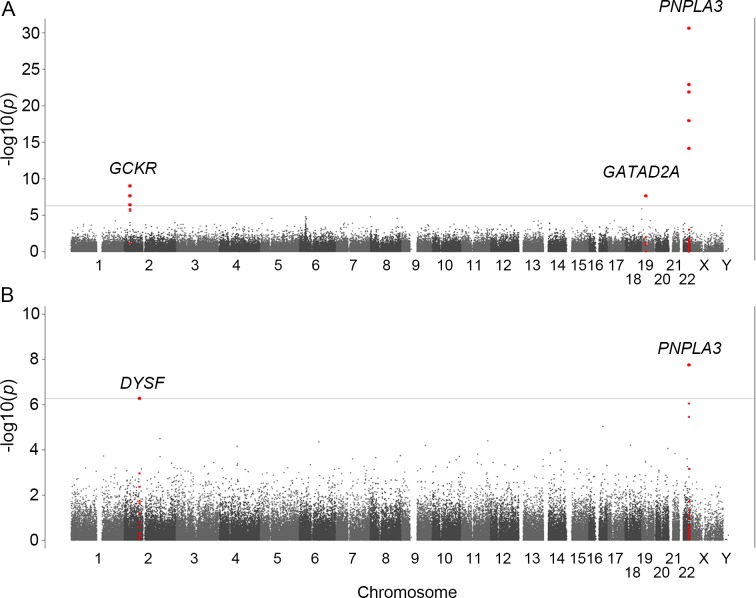
Manhattan plots of the GWA data.The p-values for genotyped SNPs from the GWA study for all NAFLD patients (A) and for NASH-HCC patients (B) compared to controls are plotted along each chromosome in −log10 scale. Horizontal line indicates the Bonferroni significance threshold (p = 5.3×10−7).